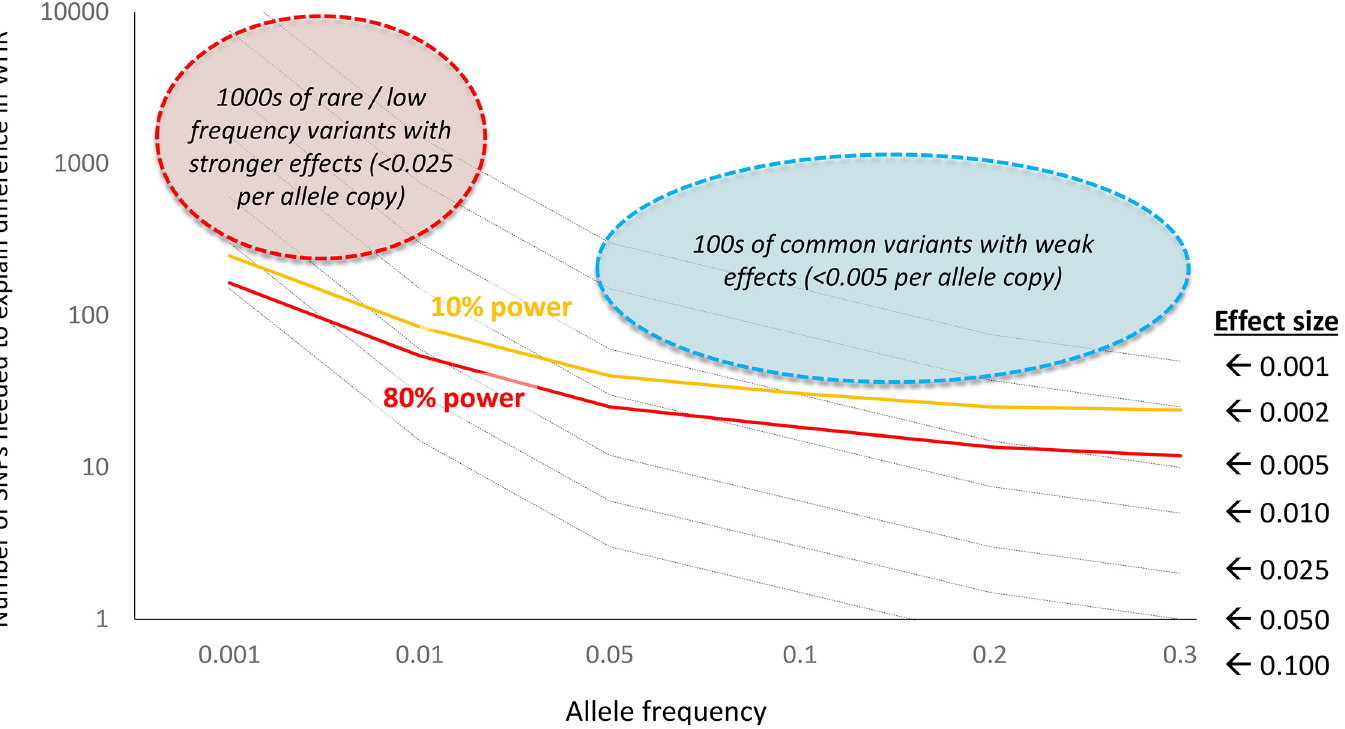
Fig 2. Contribution of population-specific genetic variants to increased WHR amongst South Asians compared to Europeans. Results are shown as the number of SNPs needed to fully explain the difference in WHR between the populations across a range of effect sizes (per allele copy, dashed black lines). Superimposed are lines showing the power (10% power, orange line; 80% power, red line) of the current study to detect common and low frequency genetic variants associated with WHR amongst South Asians. Results show that our study sample size is sufficient to identify common variants with effect size > 0.005 per allele copy, and rare / infrequent variants with effect size > 0.025 (untransformed β values). At these effect sizes, there would need to be 10s to 100s of population-specific genetic variants to explain increased WHR amongst South Asians. At effect sizes smaller than those identifiable in the current study, there would need to be 100s of common variants or 1000s of rare / low frequency variants that are population-specific and associated with WHR, to account for increased WHR amongst South